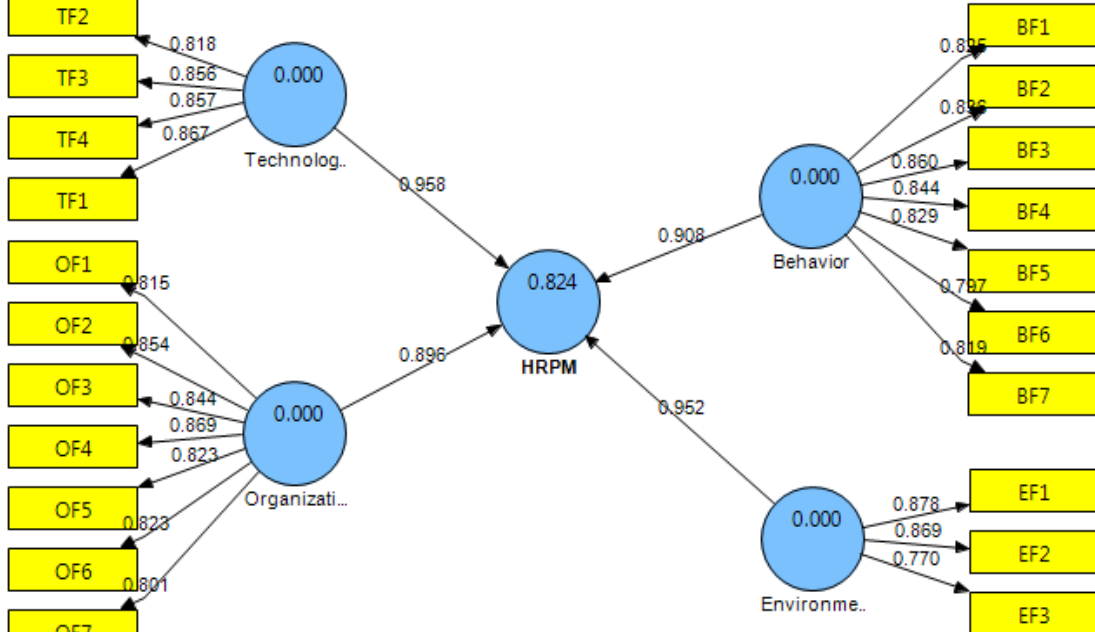
Fig. 3: The original model in the mode of path coefficients